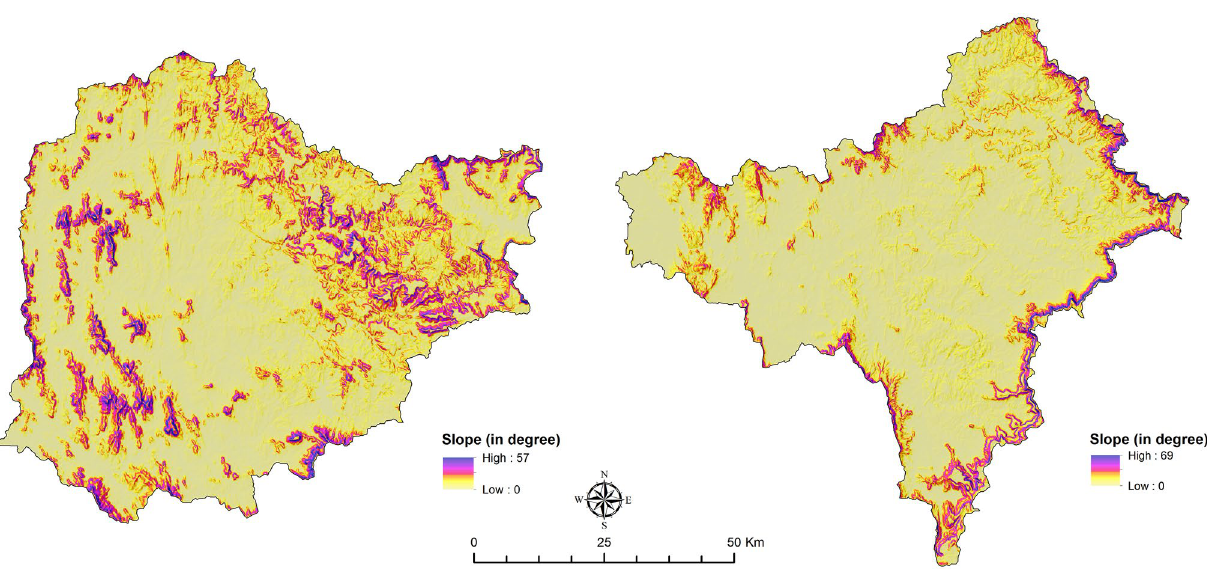
Fig. 7 Slope maps of Vaitarna and Ulhas basins are showing the degree of inclination of land concerning the horizontal ground